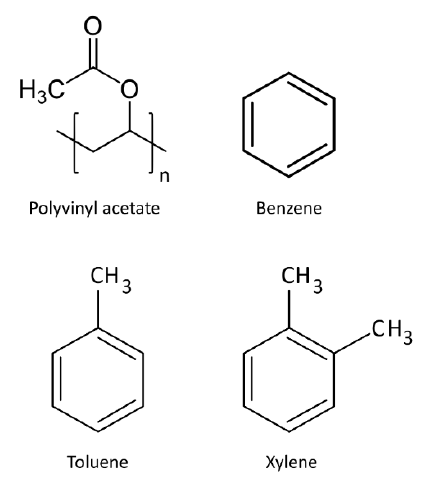
Figure 1. Chemical structure of polymer and analyte used in this study.